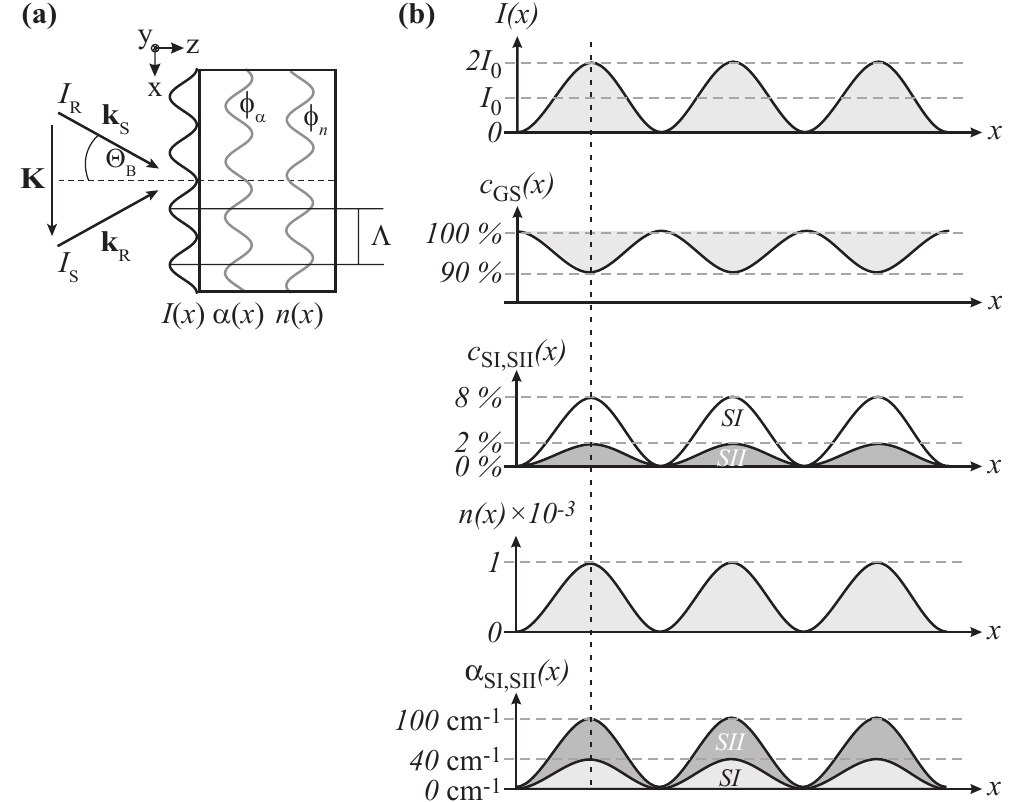
Figure 5. ( a ) Scheme of hologram recording via two beams; ( b ) In SNP the illumination with a sinusoidal light pattern results in spatially modulated number densities ( c ( x ) ) leading to a modulation of the refractive index n ( x ) and the absorption and c SII coefficient α ( x )